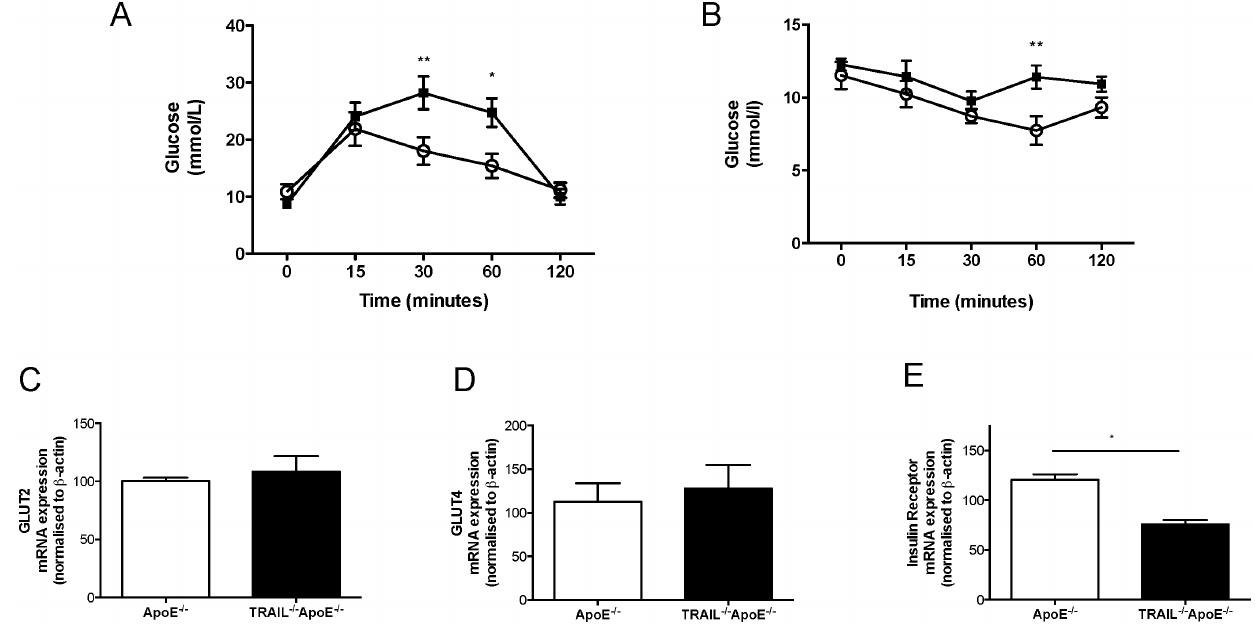
Figure 4. TRAIL -/- ApoE -/- mice show impaired glucose and insulin tolerance and kidneys have altered insulin signalling. (a) Glucose and (b) insulin tolerance tests of ApoE -/- (open circles) and TRAIL -/- ApoE -/- ( & ) mice (n=6–11/genotype). mRNA levels for (c) GLUT2, (d) GLUT4 and (e) insulin receptor were measured in the kidney. All mRNA levels were normalized to b -actin; n=5-6/genotype. Results expressed as mean 6 SEM, *p , 0.05, **p , 0.01, ***p , 0.001 and ****p , 0.0001 by Mann-Whitney U test and ANOVA.